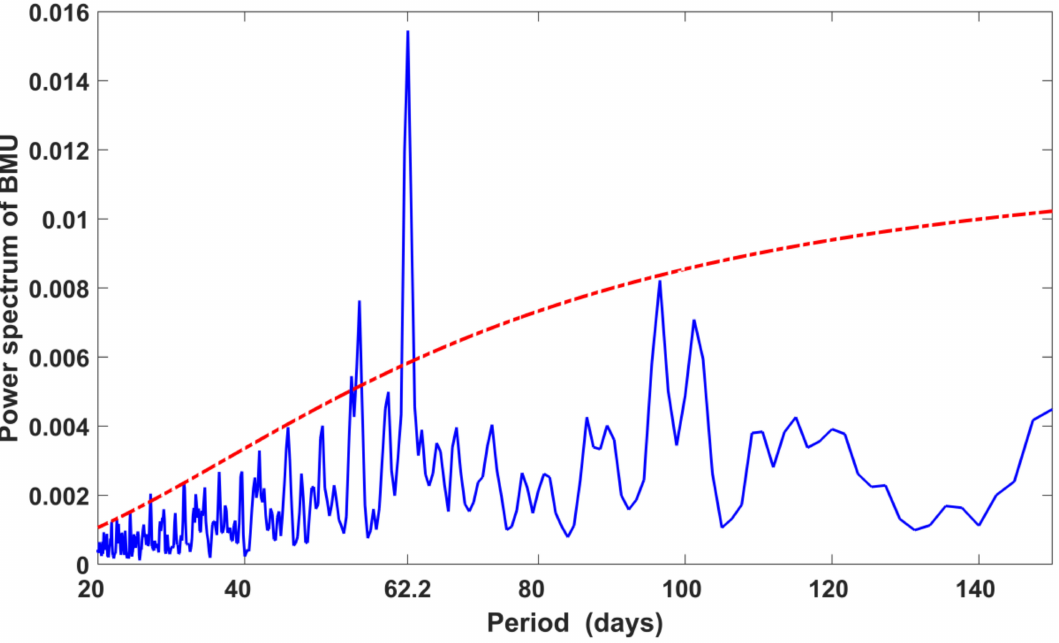
Figure 5. Power spectrum analysis of time series of the BMU for the four patterns. The red dotted line represents the 95% significant